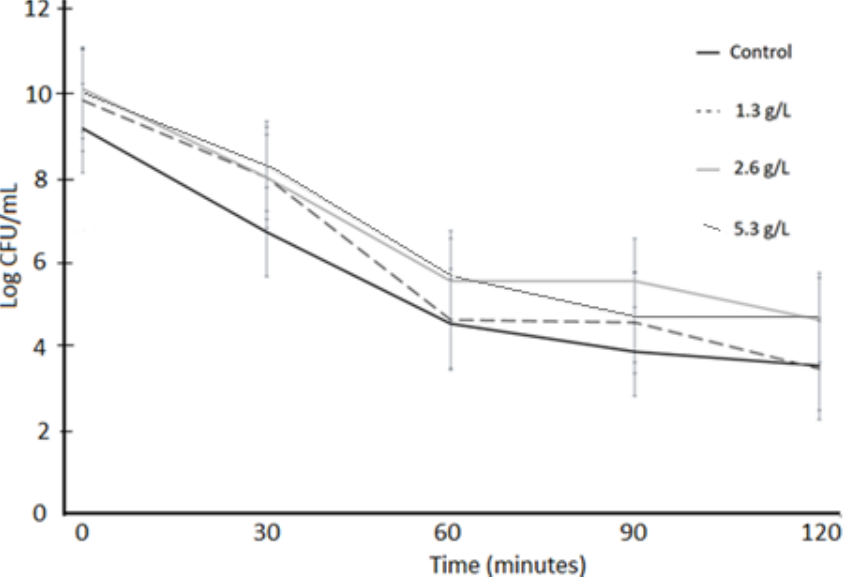
Figure 3. Log counts of S. thermophilus to show acid tolerance as influenced by carao concentration over an incubation period of 120 min.